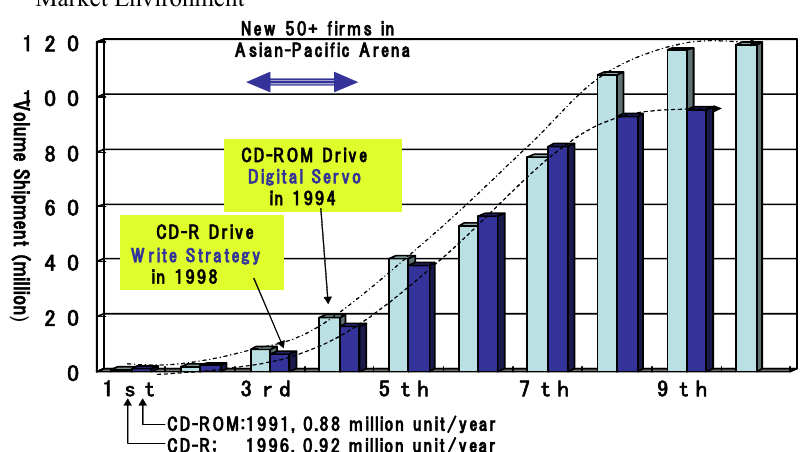
Figure 3. Market Expansion after Product-architecture Change in Computer Market Environment